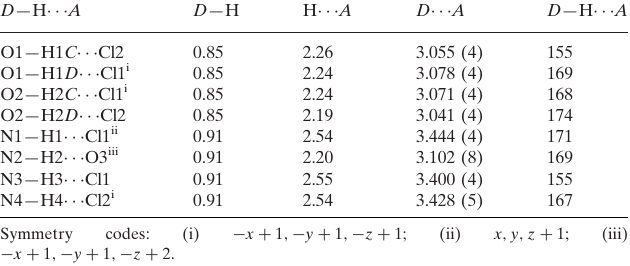
Hydrogen-bond geometry (A˚ , (cid:3)